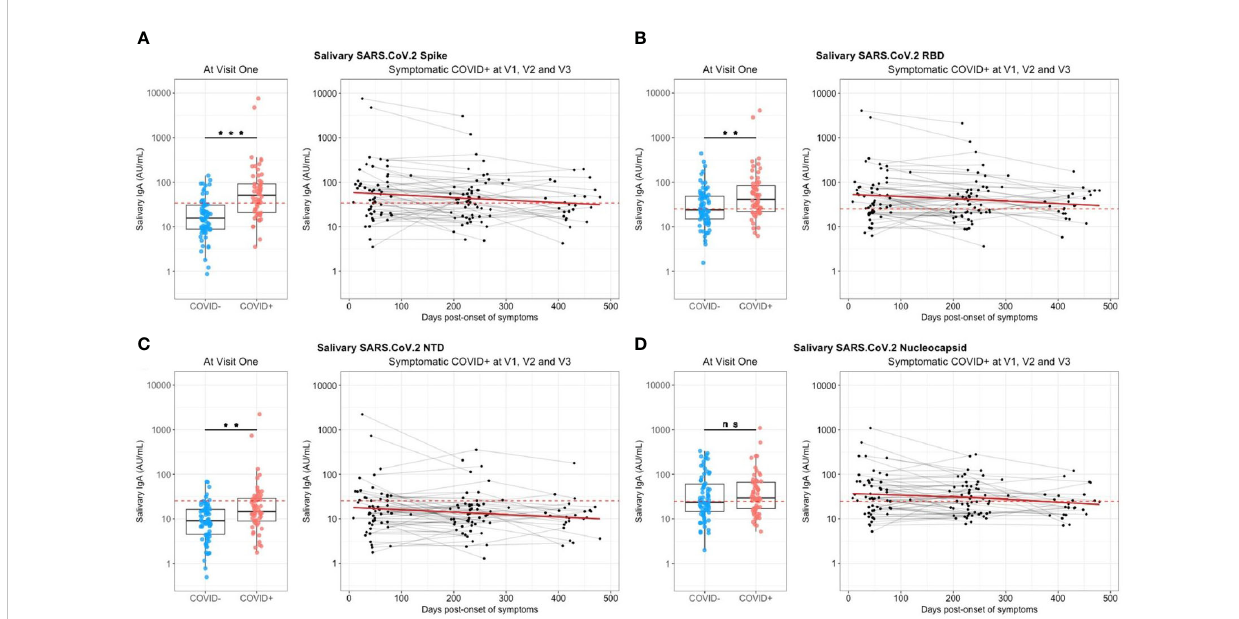
FIGURE 3 Saliva anti-SARS-CoV-2 IgA kinetics and speci fi city up to 16 months after COVID-19 acute infection and without immunization. Saliva anti-SARS- CoV2 IgA (UA/ml) were quanti fi ed on a MesoQuickPlex SQ120 using the V-PLEX COVID-19 Coronavirus Panel 2 IgA kit, from naive (COVID-, blue) and previously infected (COVID+, red) individuals at enrollment (V1, boxplots on the left), and its kinetic of decrease (mean slope in red) for symptomatic infected individuals up to 16 months after the acute infection (timeline evolution of the signal on the right). (A) Salivary IgA titers against the whole Spike. (B) Salivary IgA titers against the Spike/RBD. (C) Salivary IgA titers against the Spike/NTD. (D) Salivary IgA titers against the Nucleocapsid. The red dashed line corresponded to the positivity threshold, determined by the quantitative variable maximizing both sensitivity